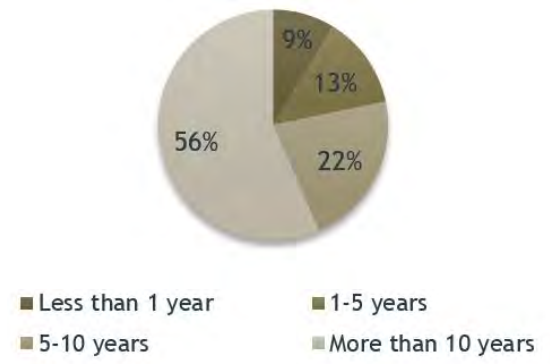
Figure 11. Period of residence.